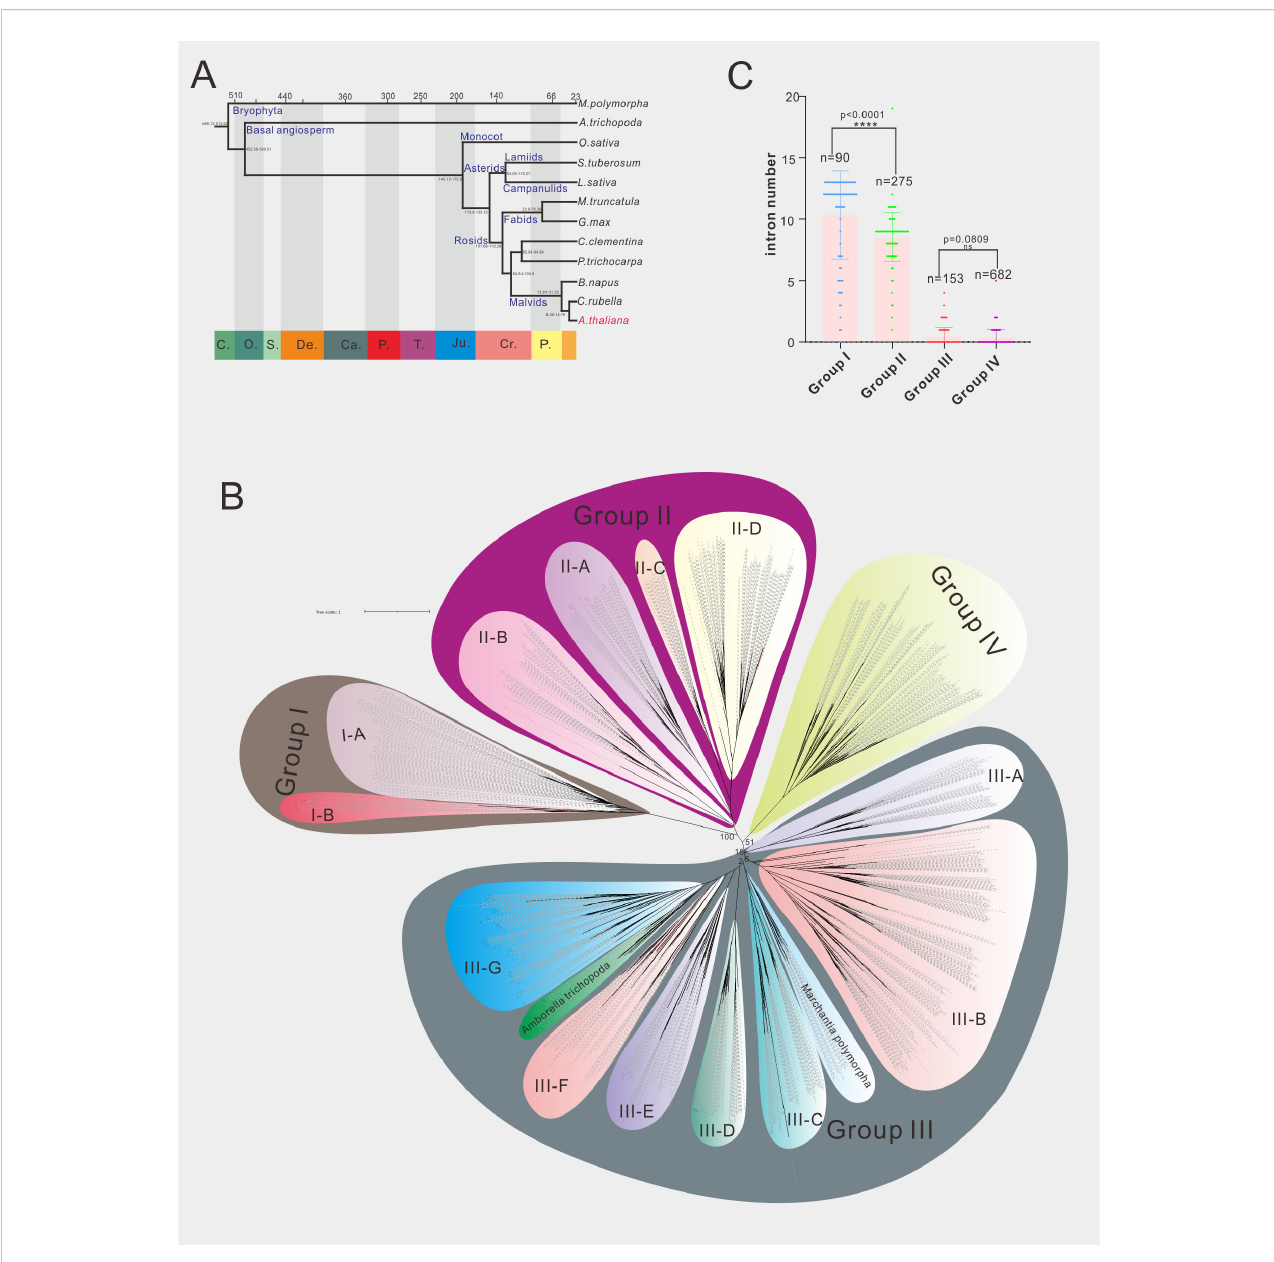
FIGURE 1 Phylogenetic analysis of A1 aspartic protease family in 12 selected species. (A) The evolution relationship of 12 selected species. The top of tree showed the absolute age, unit: million years, the bottom of the tree showed the geologic time, C, Cambrian; O, Ordovician; S, Silurian; De, Devonian; Ca, Carboniferous; P, Permian; T, Triassic; Ju, Jurassic; Cr, Cretaceous; P, Paleogene (from left to right). (B) Phylogenetic tree of A1 family members in 12 selected species, maximum likelihood method (ML) was applied with a 1000 bootstrap analysis, groups and subgroups are labeled. (C) Average intron numbers of group I-IV, n presents gene numbers in each